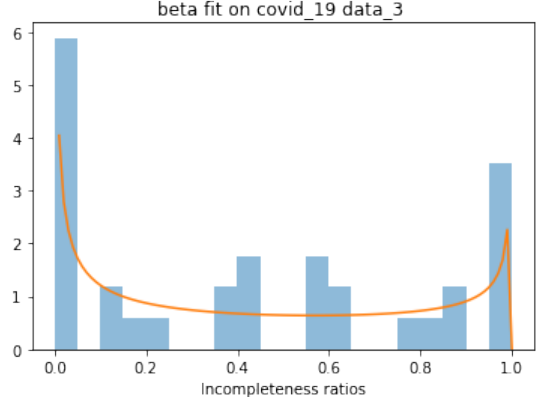
Figure 11. Fitting Provisional Counts of Death Dataset with beta